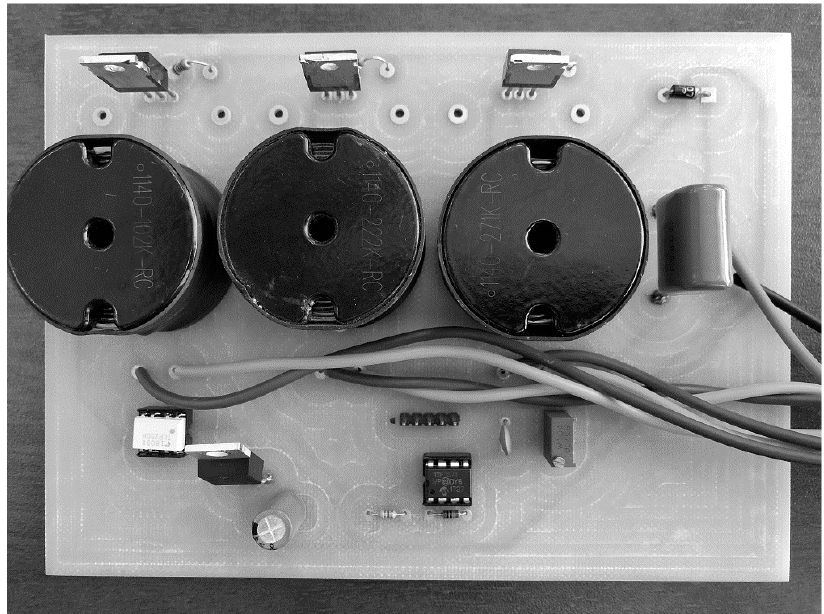
Figure 10. PCB of the experimental implementation.